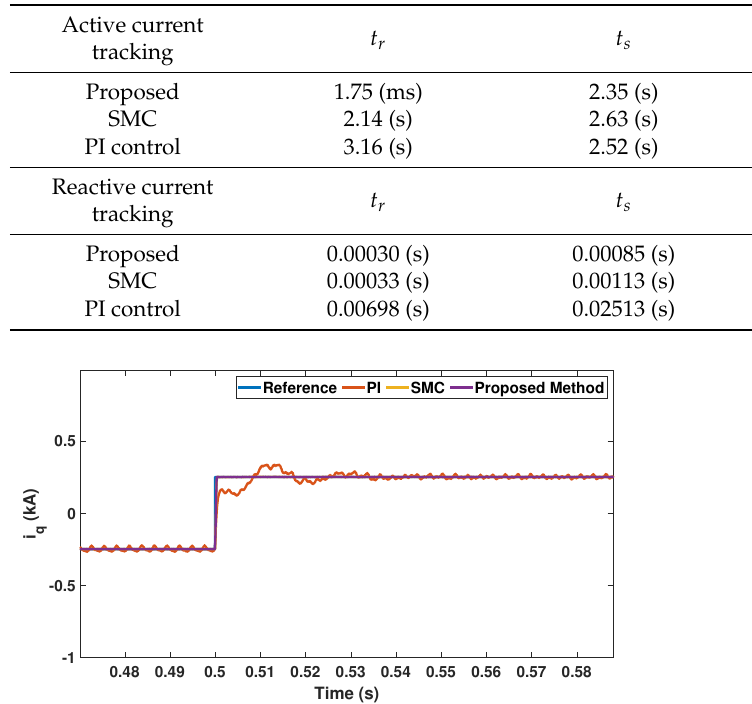
Figure 10. The trajectory of i q subjected to reactive current change.